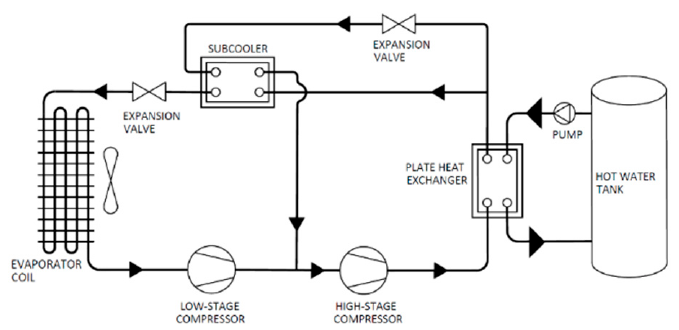
Figure 15. Schematic of the two-stage air-to-water heat pump with a sub-cooler. It consists of two compressors (low-stage and high-stage), two expansion valves, a sub-cooler, an evaporator coil for absorbing heat from the ambient environment, and a plate heat exchanger for producing hot water. The refrigerant discharged from the low-stage compressor is mixed with the two-phase refrigerant from the sub-cooler and enters the high-stage compressor in a saturated vapour state, so the discharge temperature of the high-stage compressor can be reduced. Moreover, the remaining condensed refrigerant from the plate heat exchanger is supercooled by the two-phase refrigerant in the sub-cooler